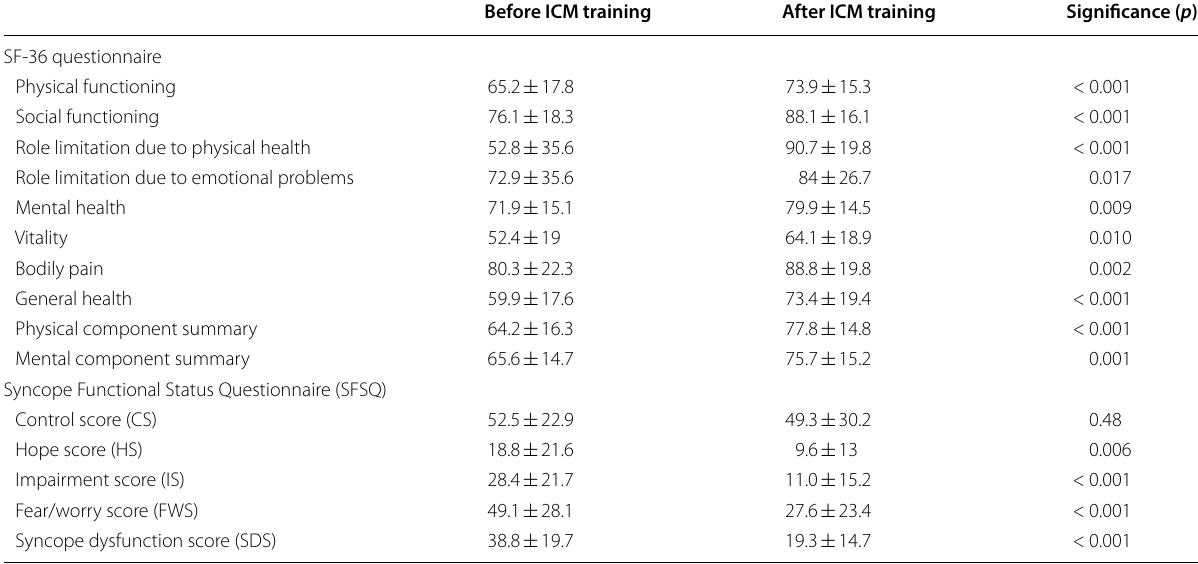
SF36 Short Form 36, SFSQ Syncope Functional Status Questionnaire